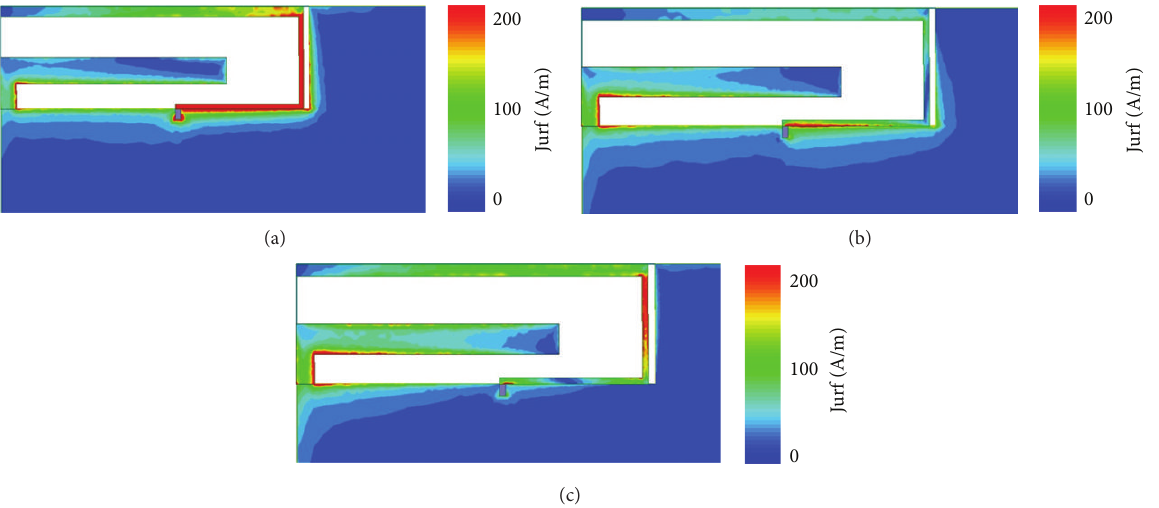
Figure 2: Simulated current distributions at different frequencies. (a) 925 MHz; (b) 1850MHz; (c) 2470